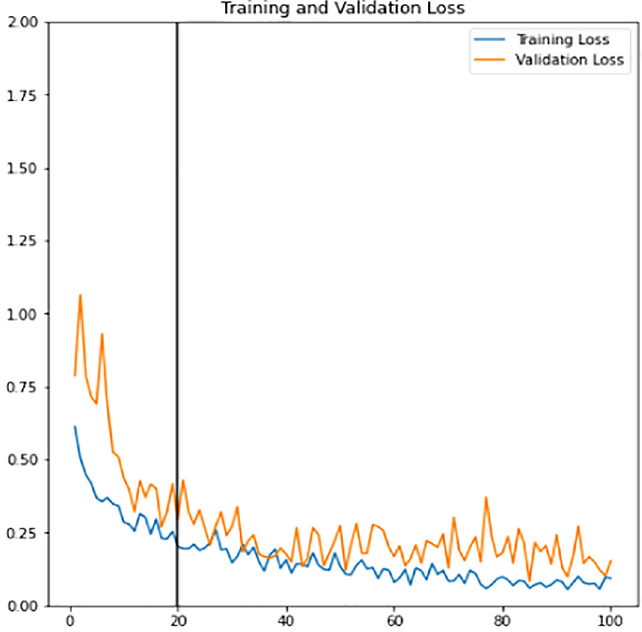
Figure 13. Training learning curve of loss for training and validation sets of the fine-tuned